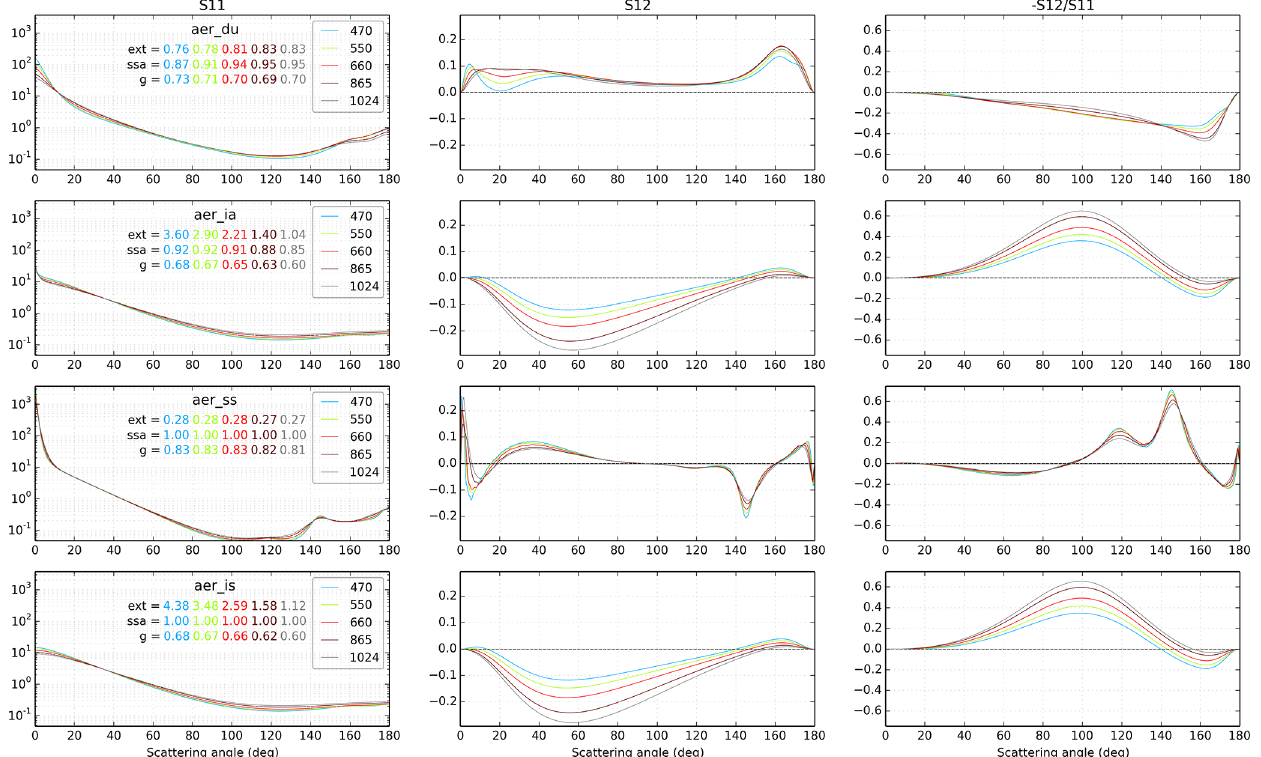
Figure 1. First (i.e. S 11 , left panels) and second (i.e. S 12 , middle panels) element of the phase matrix and linear depolarization ratio (i.e. ◦ ) for the four aerosol types (rows), where aer_du stands for dust, aer_ia for − S 12 /S 11 ) (right panels) as a function of the scattering angle ( industrial absorbing, aer_ss for sea salt, and aer_is for industrial scattering. The colour code corresponds to the five wavelengths (470, 550, 660, 865, and 1024nm). The mass extinction coefficient (ext, in m 2 g − 1 ), single-scattering albedo (ssa), and asymmetry parameter ( g ) are S 11 ((cid:50)) sin (cid:50) d (cid:50) = 2 (cid:1) also indicated in each panel. The phase function is normalized to 2 (cid:0) i.e. R π 0